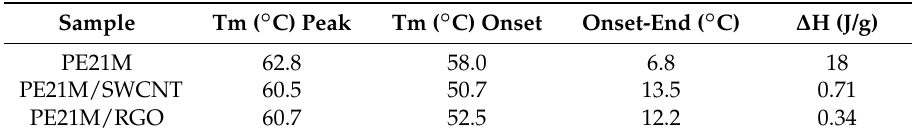
Figure 7. First heating curves of PE21M and PE21M/nanofiller composites produced at 50 ◦ C and 15 MPa SC CO 2 pressures in DSC measurement at a constant heating rate of 10 ◦ C/min. ( a ) PE21M/SWCNT nanocomposites, and ( b ) PE21M/RGO nanocomposites. Table 7. Melting data of PE21M and PE21M/nanofiller composites produced at 15 MPa SC CO 2